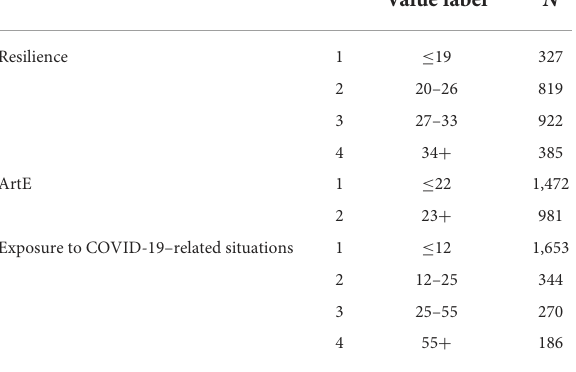
TABLE 4 Between-subjects